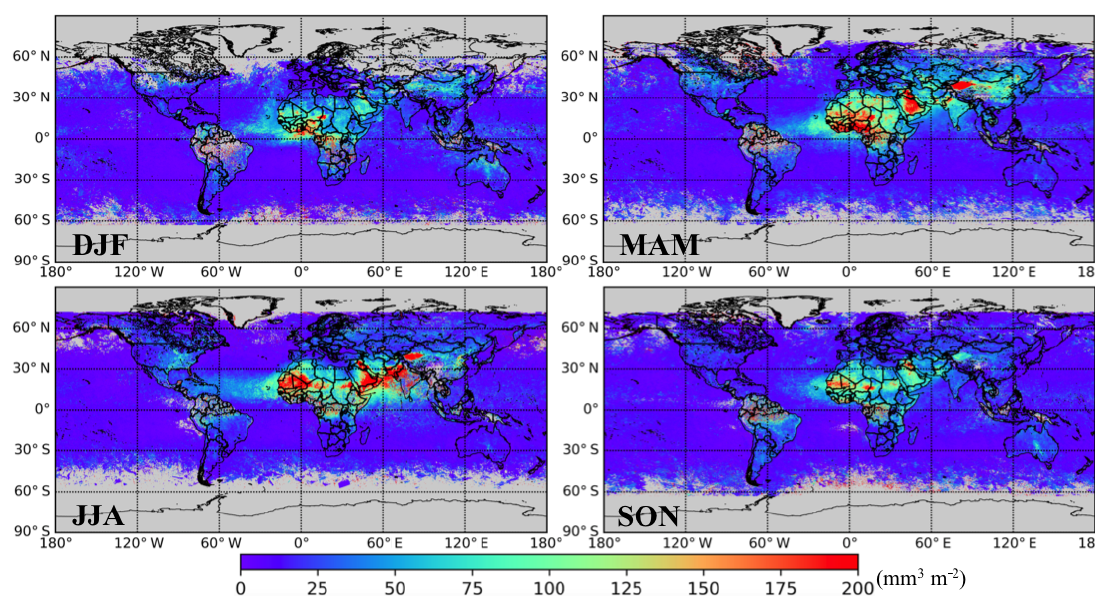
Figure 19. Same as Fig. 16, but for coarse-mode non-absorbing insoluble (CNAI, dust).